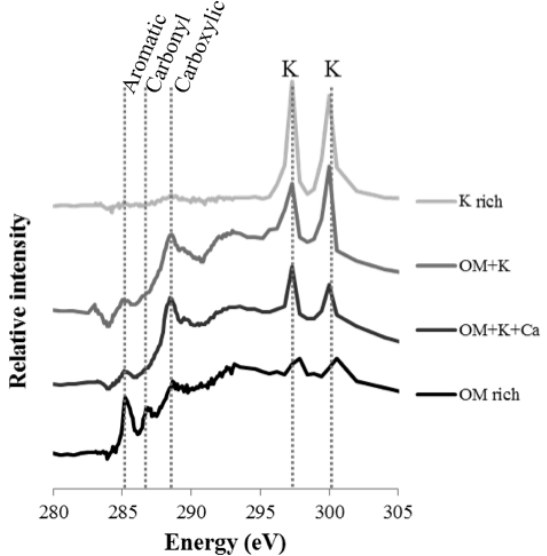
Figure 5. Selected NEXAFS spectra of the four types of particles identified in the clay subfractions by STXM. Individual spectra are shifted on the intensity axis for better discrimination. Unlabeled peaks at 297.1 and 299.7eV correspond to potassium (K) L-edge peaks. The spectra correspond to OM-rich particles with very lit- tle mineral (darkest color), organomineral particles with K and Ca mineral phases, organomineral particles with K-minerals, and K- rich phases (lightest